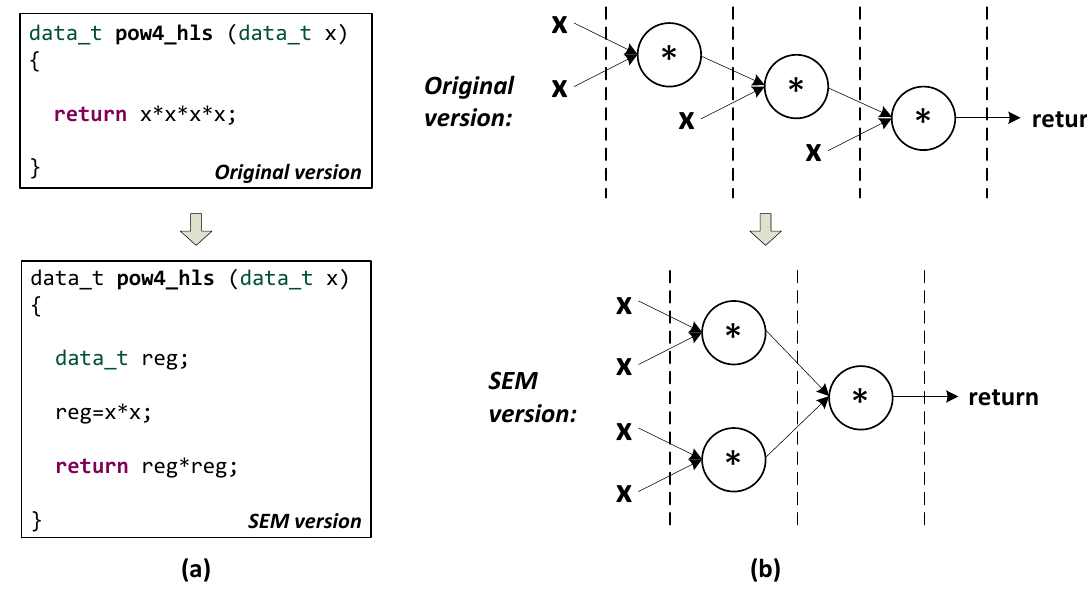
Figure 5. Scheduling of pow4_hls : ( a ) original-to-Symbol Expression Manipulation (SEM) code transformation; ( b ) scheduling